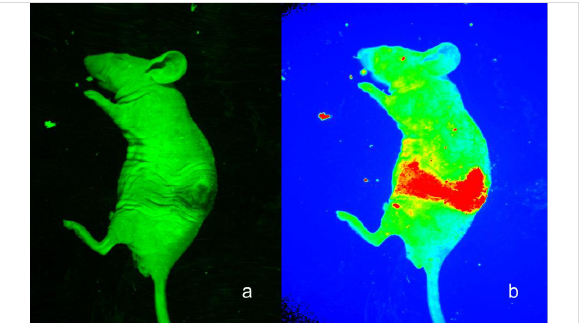
Figure 12: In vivo whole body imaging of nude mouse injected with F127-CdS/ZnS QDs, (a) transmission image, (b) luminescence